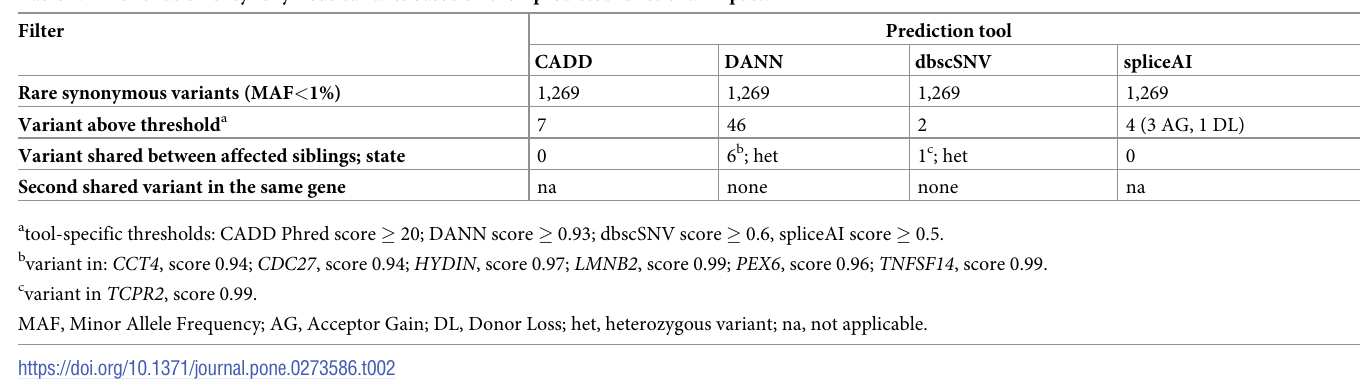
Table 2. Prioritization of synonymous variants based on their predicted functional